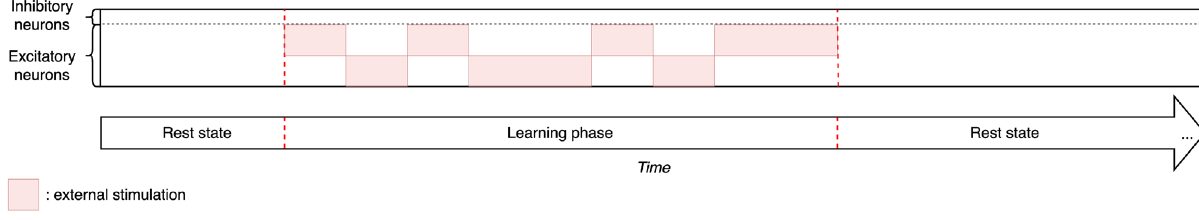
Figure 2. Diagram representing the stimulation protocol divided in three phases: a first short phase of spontaneous activity, a learning phase during which two different groups of excitatory neurons are stimulated alternatively over time (the red areas represent the duration and the neurons that received external stimulation), and a final long period of resting-state activity in which the plasticity remains